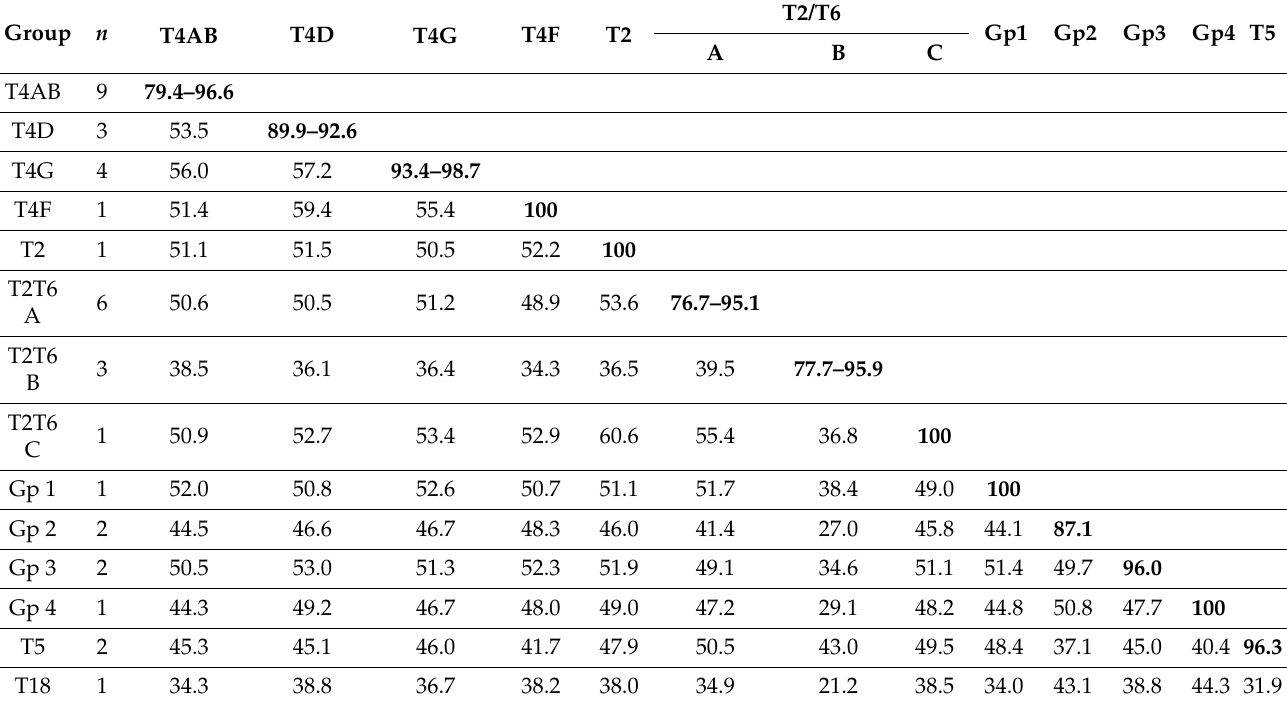
Table 2. Acanthamoeba ITS-2 mean similarity values